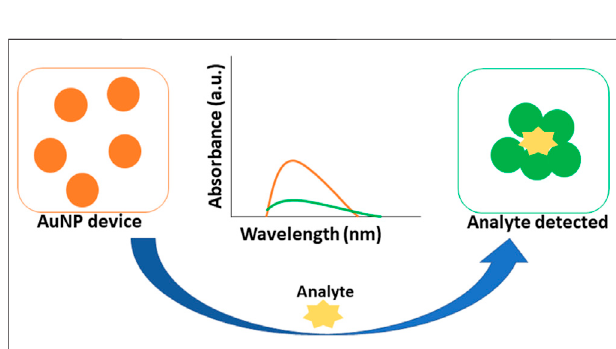
FIGURE 7 | AuNP based colorimetric